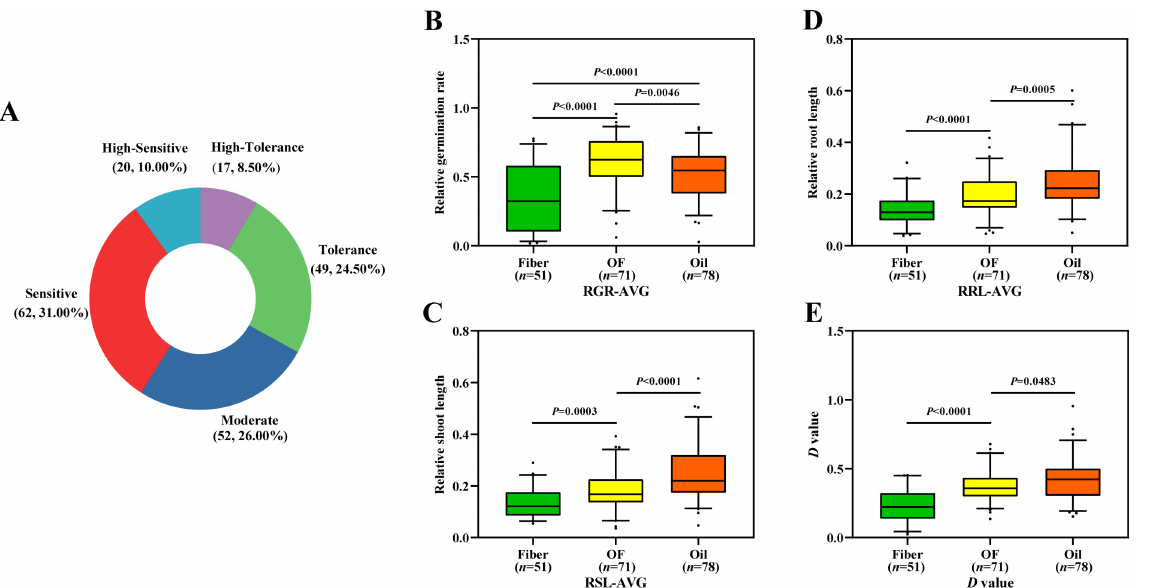
Figure 2. Evaluation of salt tolerance of flax germplasms. ( A ) Salt tolerance grades of 200 accessions of flax; ( B – D ) Distribution of salt tolerance indexes in subpopulations; ( B ) RGR-AVG; ( C ) RSL-AVG; ( D ) RRL-AVG; ( E ) D value. The difference between subpopulations was analyzed by t